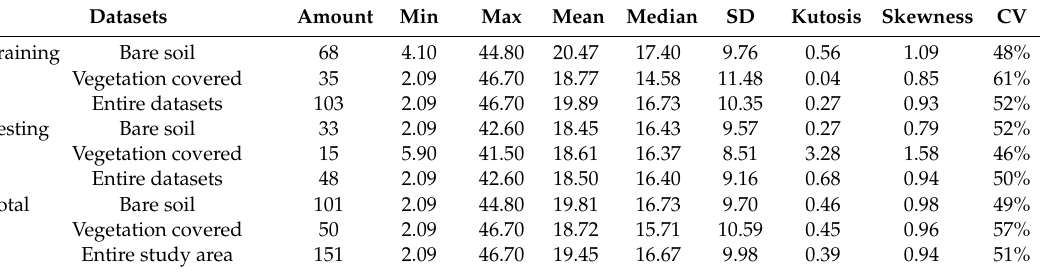
Figure 2. Spatial distribution and violin plot of training and testing datasets. Table 4. Descriptive statistics of EC (dSm − 1